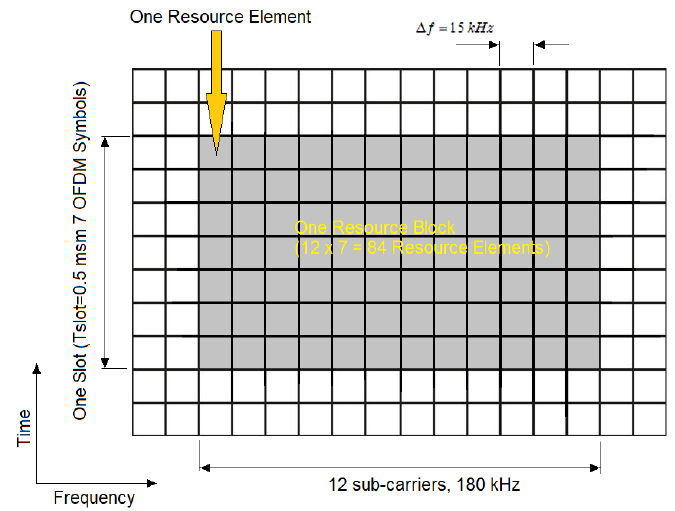
Figure 3. Structure of physical block of resource elements (adapted from [36]).